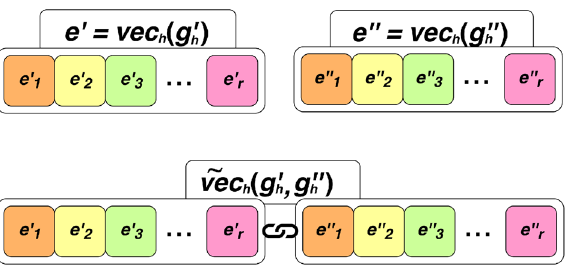
) and e ′′ ) of the human genes g ′ vec h ( g ′ vec h ( g ′′ h h = =